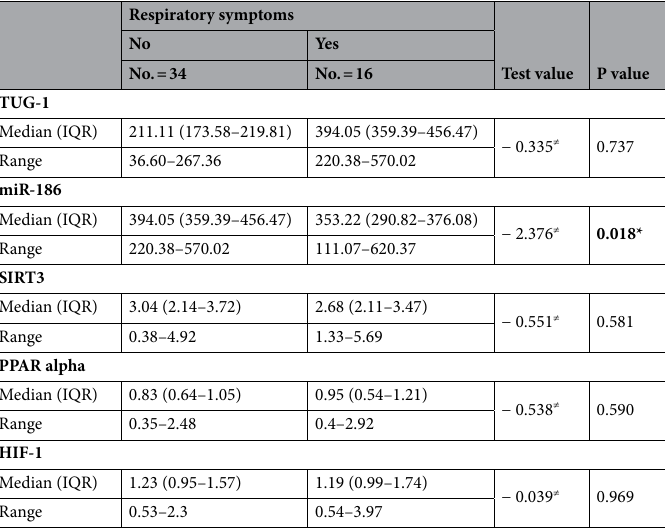
Table 2. Relationship between respiratory symptoms and the different studied parameters in TMX‑resistant group. P value > 0.05: non significant; P value < 0.05: significant*; P value < 0.01: highly significant**. Significant values are in [bold]. ≠ Mann–Whitney test.